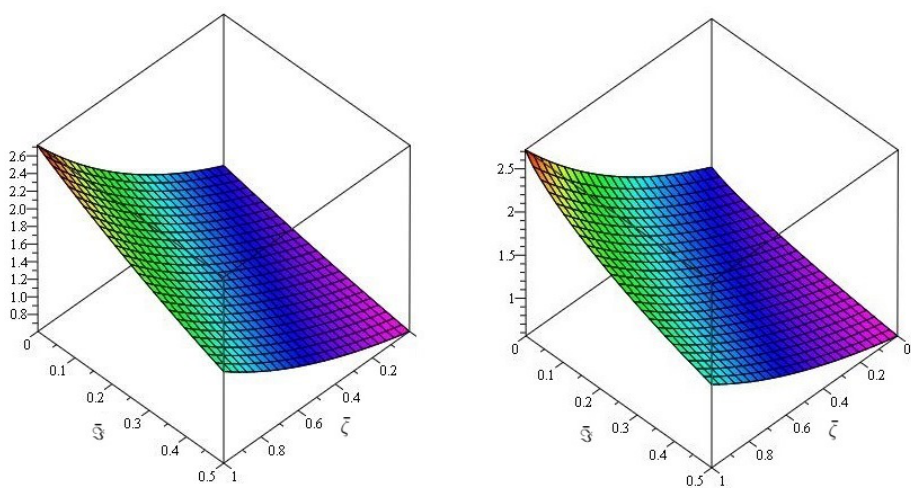
Figure 4. The first graph of analytical solution of β = 1 and second is β = 0.8 for Example 2.